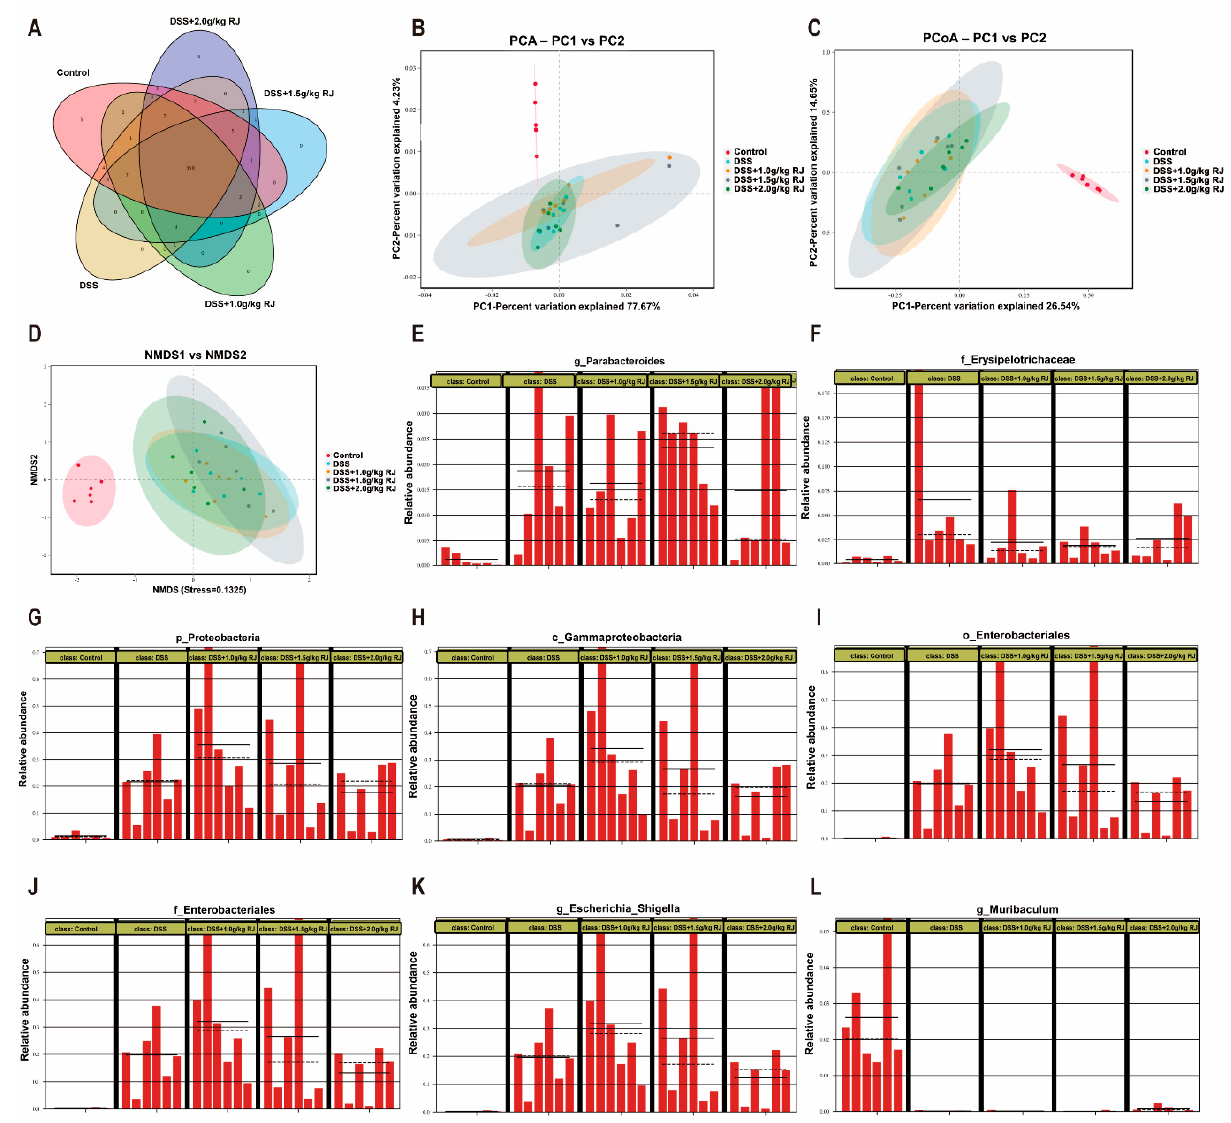
Figure 6. Oral administration of royal jelly altered the microbial composition of the colon in DSS- treated mice. ( A ) Veen diagram of colonic microorganisms OTUs. ( B ) Principal component analysis (PCA) of colonic microorganisms. ( C ) Principal coordinates analysis (PCoA) of colonic microorgan- isms. ( D ) Non-metric multi-dimensional scaling (NMDS) of colonic microorganisms; comparison diagram of abundance of Parabacteroides ( E ), Erysipelotrichaceae ( F ) and Proteobacteria ( G – J ) ( Gammapro- teobacteria , Enterobacteriales and Enterobacteriaceae ), Escherichia Shigella ( K ) and Muribaculum ( L ) for significance analysis of differences between groups. The solid and dashed lines represent the average and median of the relative abundance in each group of samples ( n = 6).